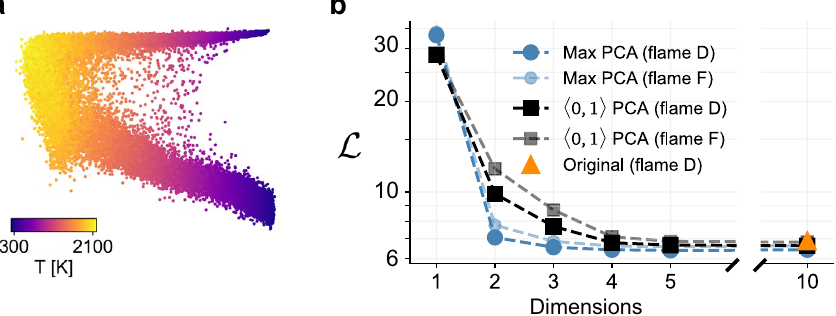
Figure 6. Cost function applied to PCA projections of experimental Sandia flame data. ( a ) A 2D projection of flame D using PCA with Max scaling colored by temperature. ( b ) The overall cost, L , computed as the L 1 -norm over the individual costs for selected dependent variables: temperature and six important chemical species mass fractions when using PCA for reduction between one and ten dimensions. The figure includes curves for using Max and (cid:31) 0, 1 (cid:30) scalings with PCA as well as the cost for the original ten-dimensional